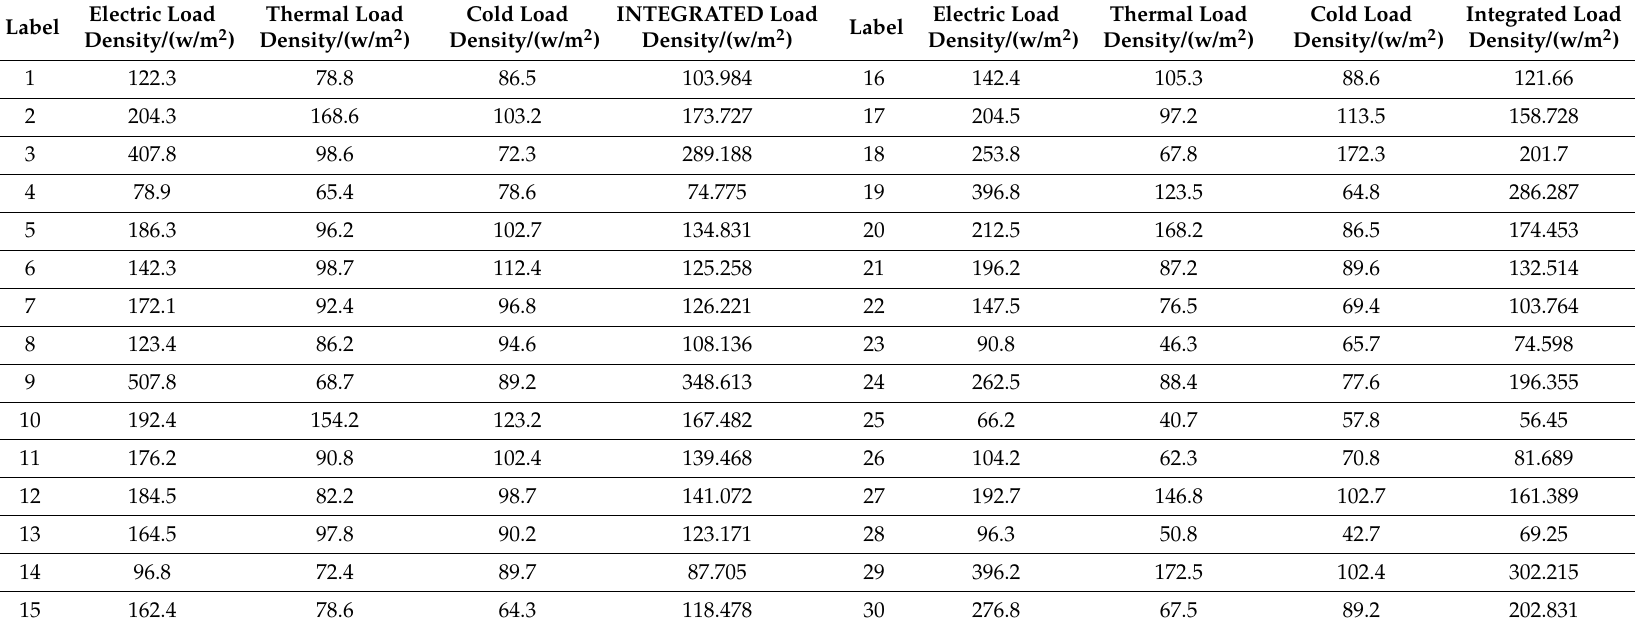
Table A2. Load density values in various functional